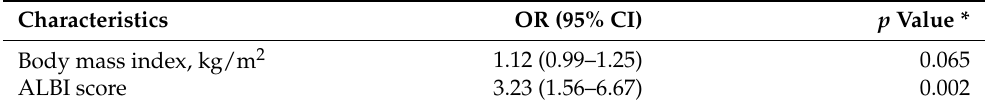
Table 2. Predictors associated with selenium deficiency in patients with chronic liver disease.